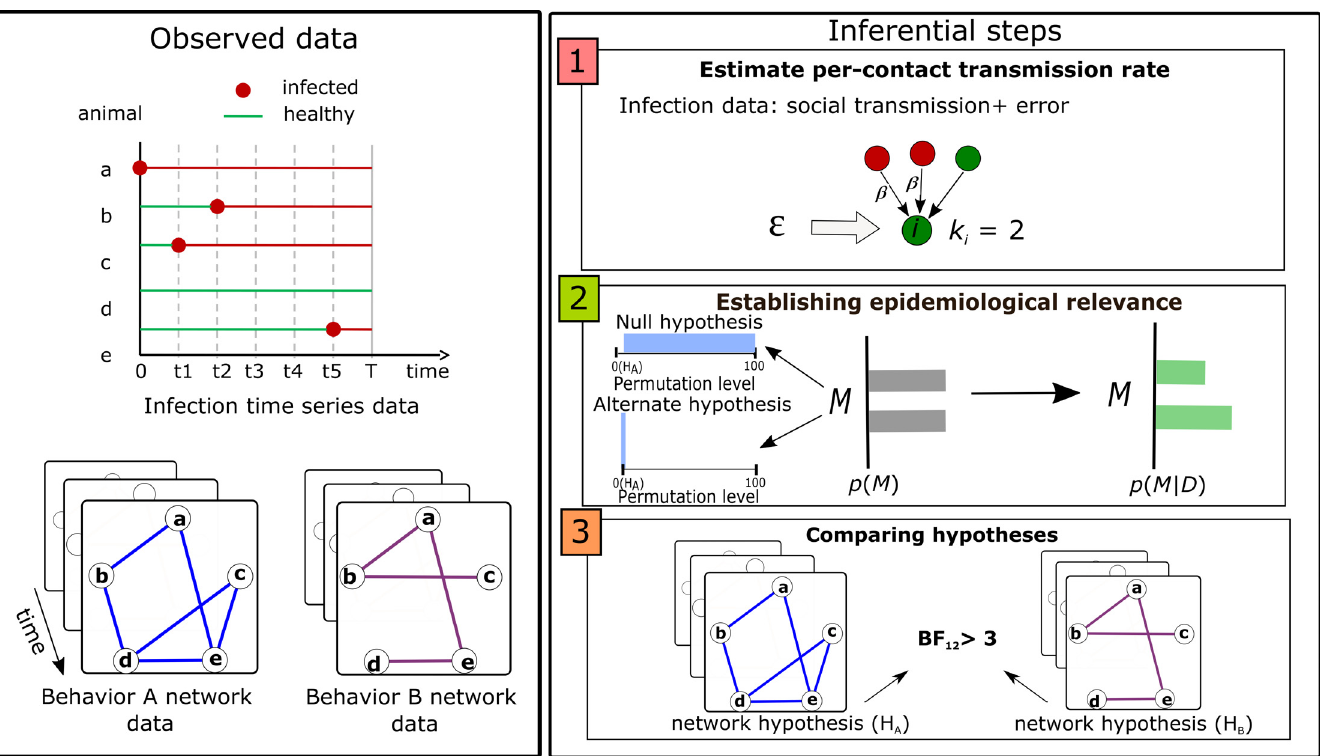
Fig 1. A schematic of our algorithm. Observed data (left panel): INoDS utilizes an observed infection time-series data to estimate statistical evidence towards a static or dynamic contact network hypothesis (or hypotheses) using a three-step procedure. Shown here is an example of two competing network hypotheses based on behaviors A and B that potentially cause infection transfer. Inferential steps (right panel): In the first step, the tool estimates per-contact transmission rate parameter β , and background transmission rate parameter � which captures the components of infection propagation unexplained by the edge connections of the network hypothesis. Here, the total infected connections of the focal node i ( k ) is 2. Second, to estimate the epidemiological relevance of the network hypothesis, Bayesian hypothesis testing i is performed. The prior distribution shows that the null hypothesis ( M = 1) assumes a uniform distribution over randomized networks generated by permuting 10%— 100% of edge connections in the contact network ( H ), whereas the alternate hypothesis ( M = 2) is a spike-shaped distribution such that only the contact network ( H A 0% permutation) has non-zero probability. The distribution on model index shifts to M = 2 if the alternate hypothesis has higher posterior probability than the null. Third, model selection of competing network hypotheses is performed using Bayes Factor (BF). A Bayes factor above 2.44 is considered to be decisive support for one hypothesis over the other.